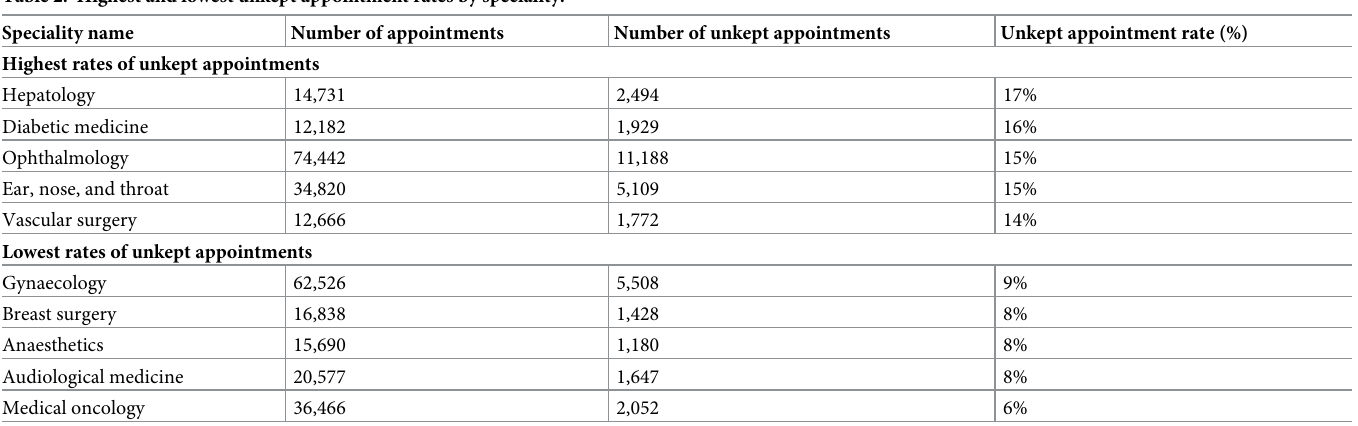
Table 2. Highest and lowest unkept appointment rates by speciality.